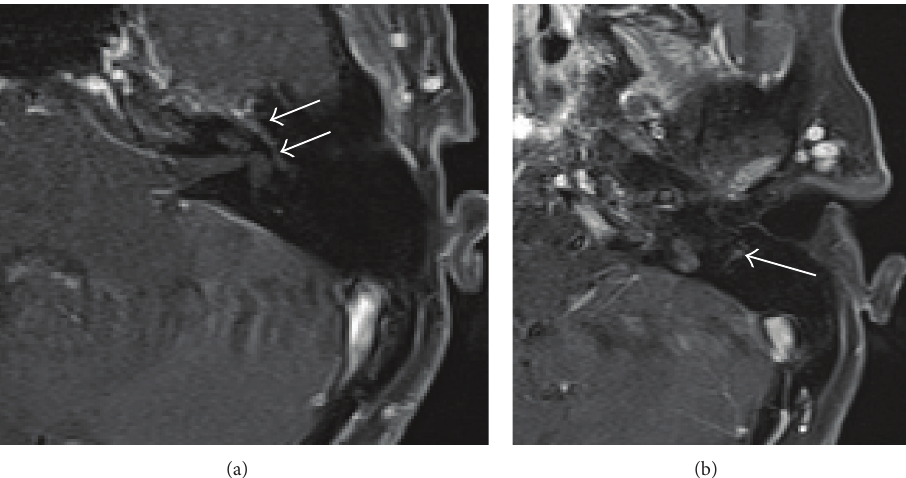
Figure 10: Normal facial nerve on MRI. Postcontrast fat-saturated T1-weighted MRI images of normal enhancing tympanic (a) and mastoid (b) CN VII